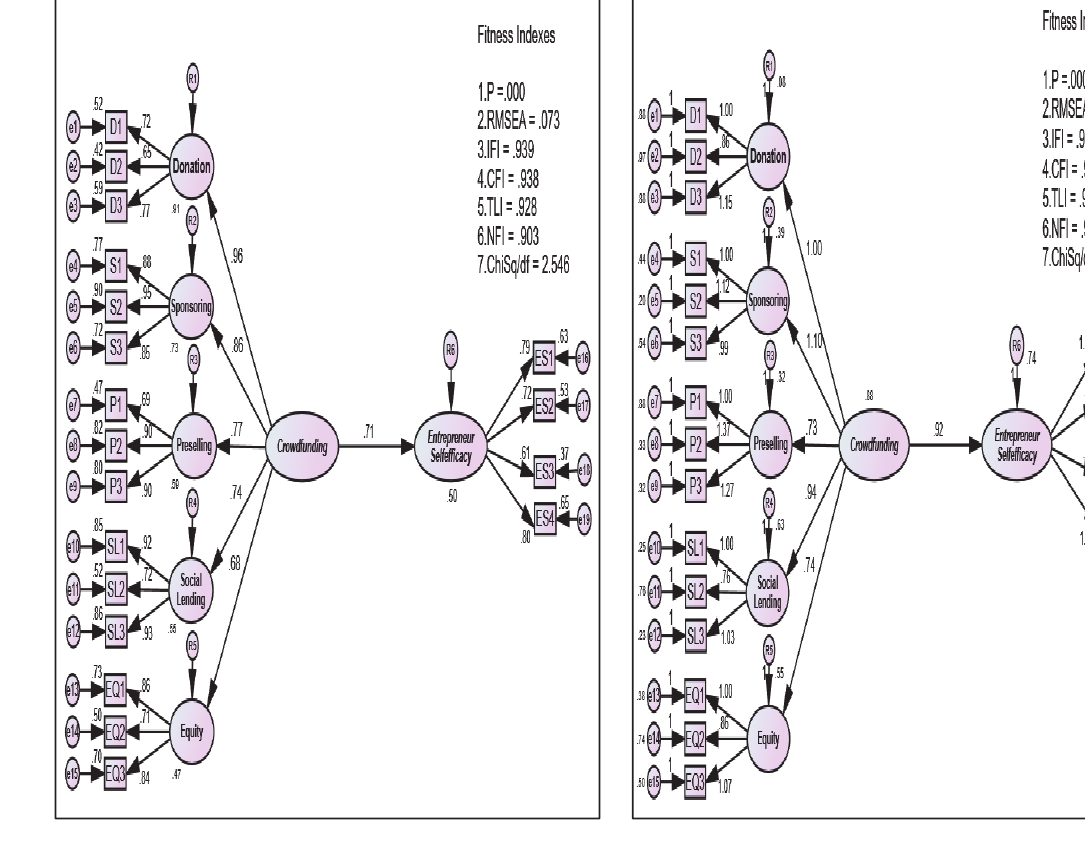
Fig. 3. Standardized Regression Path Coefficient Fig. 4. Unstandardized Regression Path Coefficient